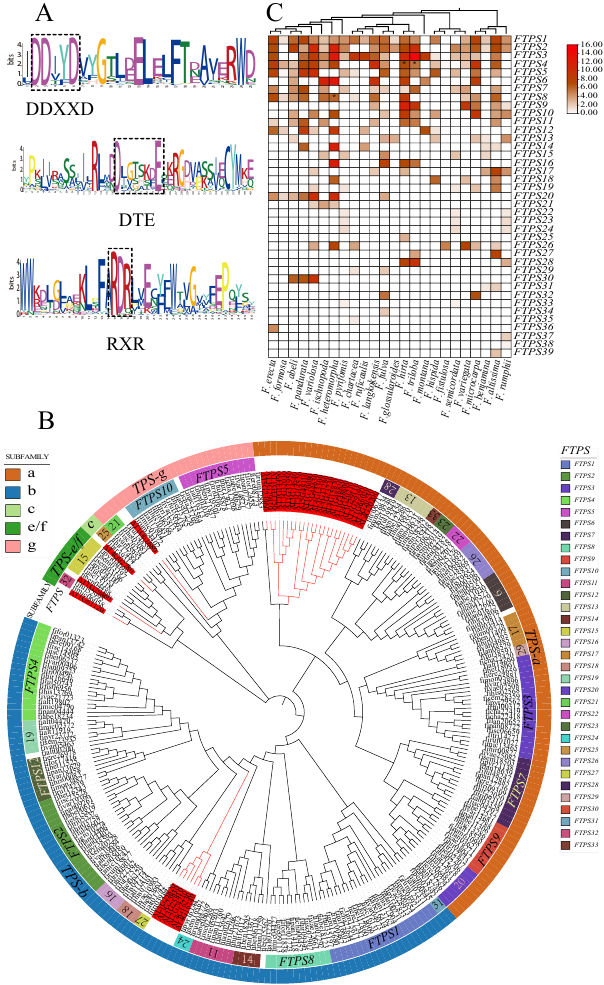
Figure 1. Sequence characteristic, phylogeny, subfamily classification, and expression profile of 248 FTPS genes. ( A ) Three conserved motif logos of the 248 Ficus genes, showing DDXXD, DTE, and RXR motif, respectively. ( B ) A maximum likelihood tree based on amino acid sequences of 248 FTPS genes and 33 A. thaliana genes, showing that these FTPSs are classified into five subfamilies and 33 orthologous genes ( A. thaliana genes are colored in red). ( C ) Expression heatmap of 248 FTPS genes across 24 species. * Genes with positive